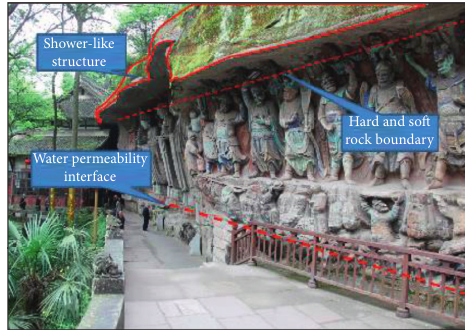
Figure 7: Topographic characteristics of statue